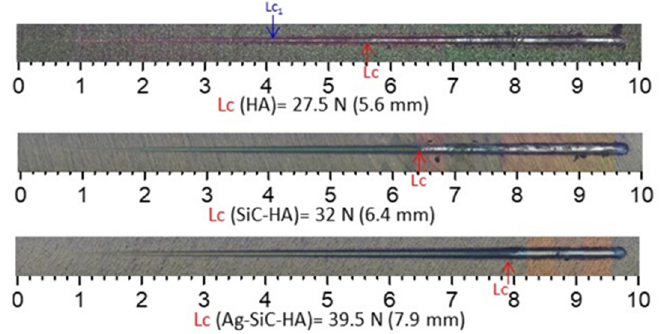
Figure 13. Scratch test results on HA-based coatings, at 50 N normal force.